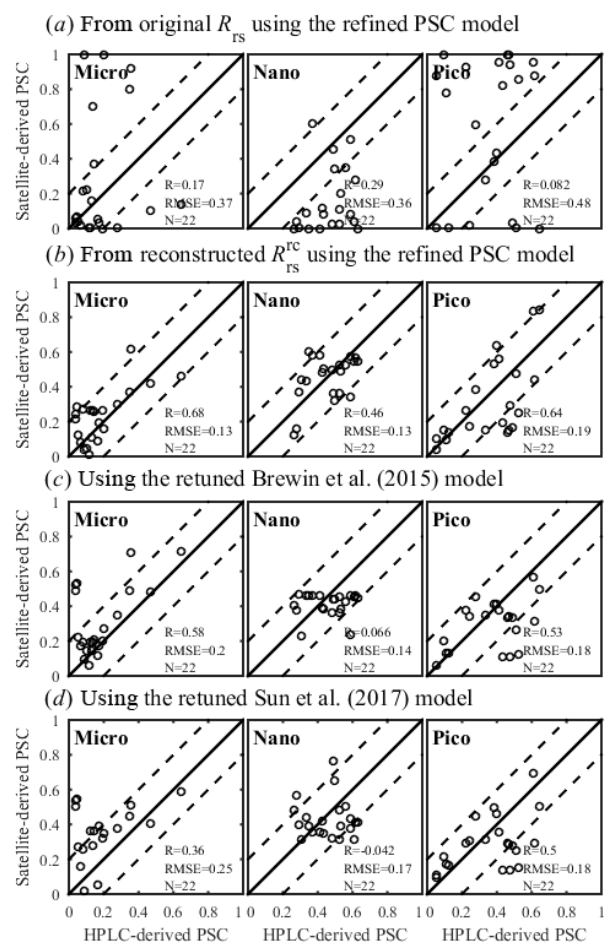
Figure 7. Comparison of the HPLC-derived PSC with the satellite- derived PSC values from the original satellite R rs (a) and the recon- structed satellite R rc rs (b) using the refined PSC model in this study; using the retuned Brewin et al. (2015) model (c) ; using the retuned Sun et al. (2017) model (d) . Solid lines denote the 1:1